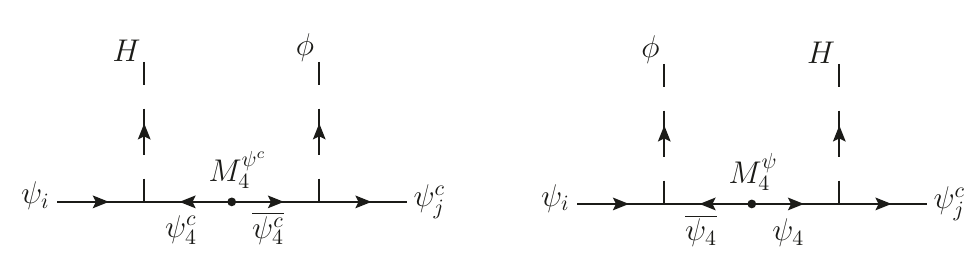
Figure 4 . Mass insertion approximation diagrams which lead to the e(cid:11)ective Yukawa couplings. H represents the two Higgs doublets H u;d .